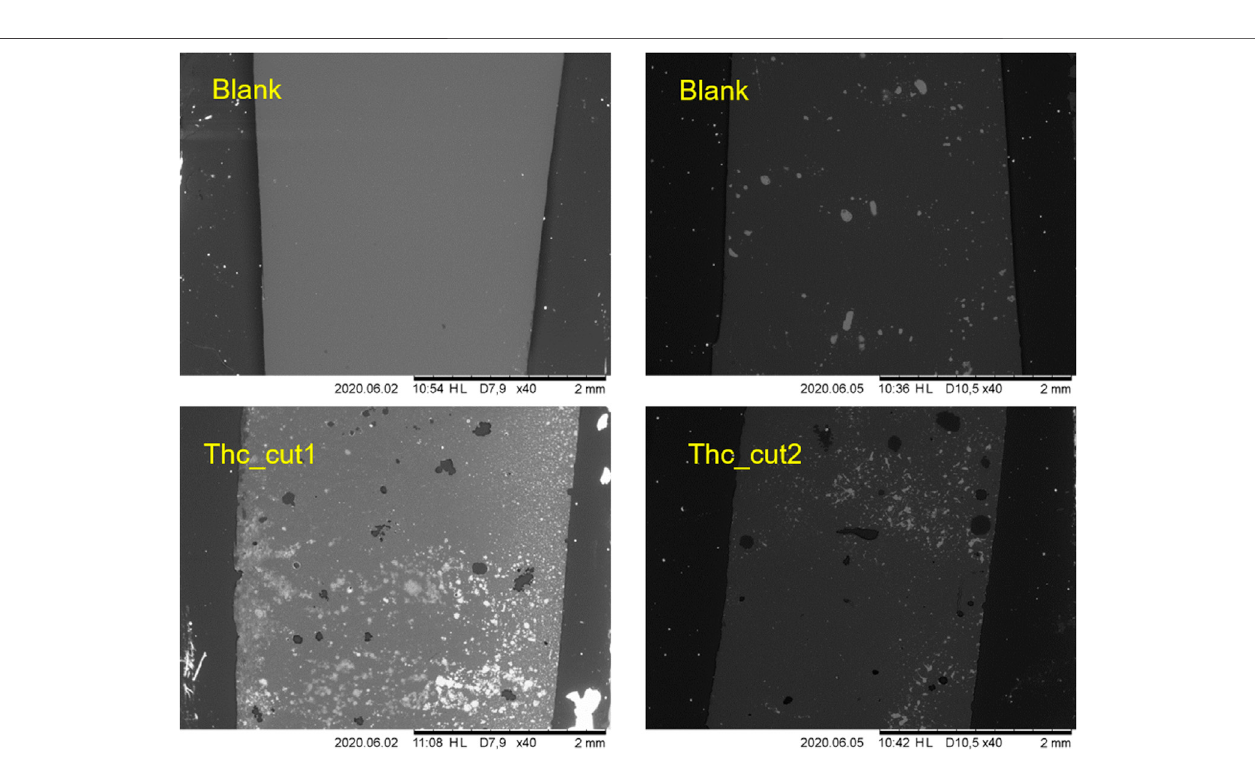
FIGURE 8 | Scanning electron microscopy (SEM) imaging of PPeTF fi lms after enzymatic hydrolysis in 1 M KPO buffer pH 8.0 at 65 ° C. Left side shows the fi lms hydrolyzed with Thc_cut1; right side shows the fi lms hydrolyzed with Thc_cut2. The upper pictures show the control reactions. Magni fi cation: 40x.